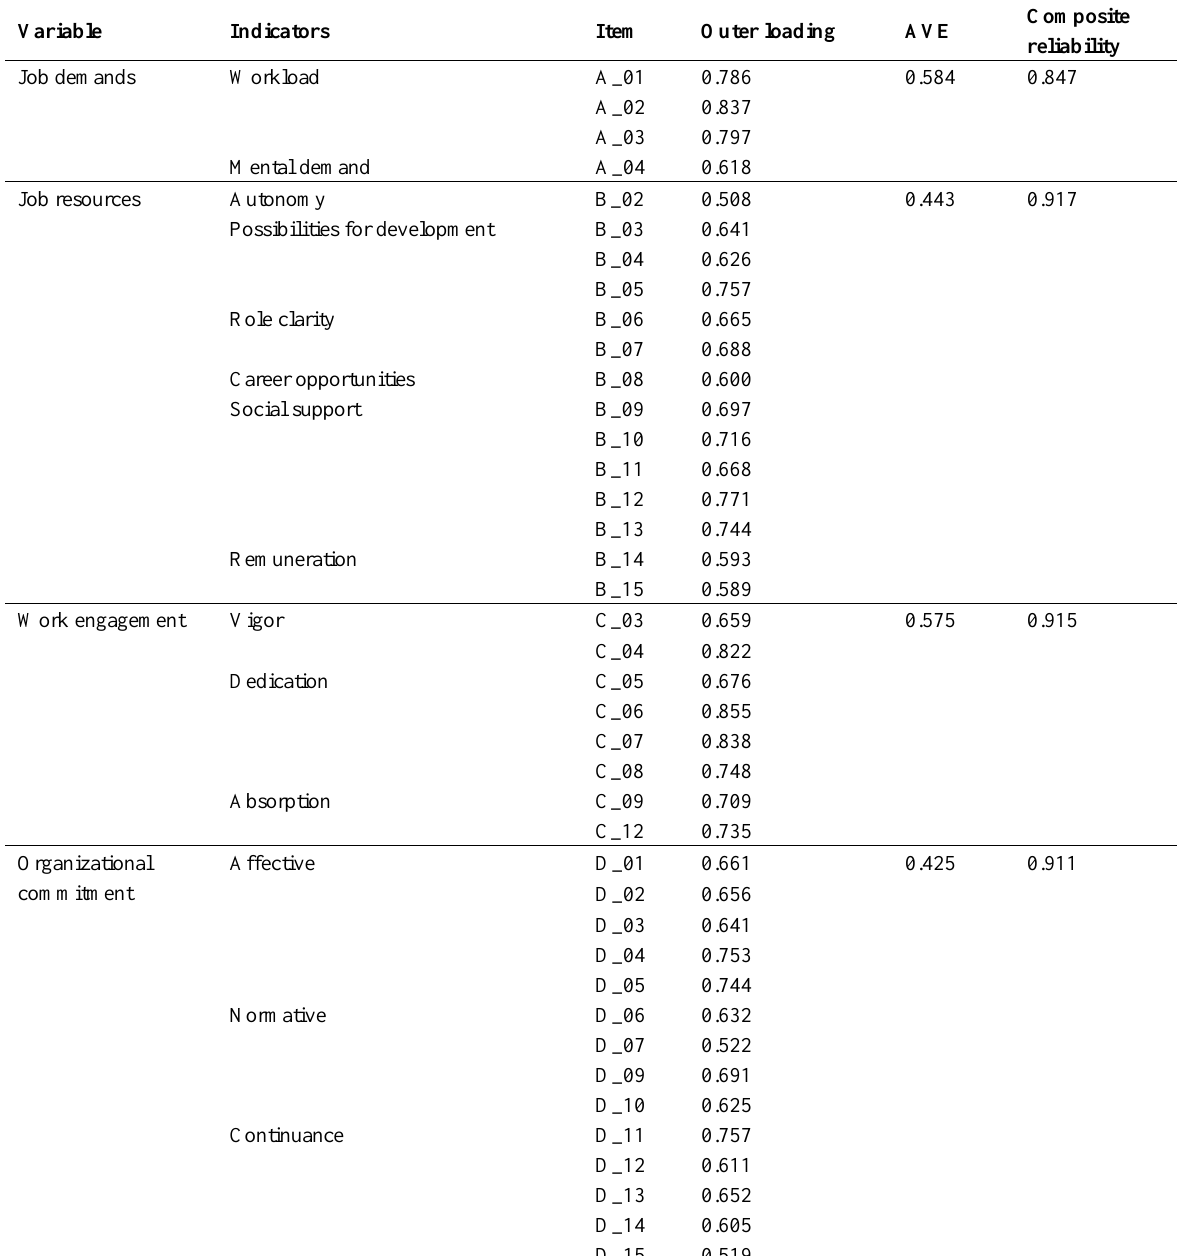
Table 2: Outer Loadings, AVE, and Composite